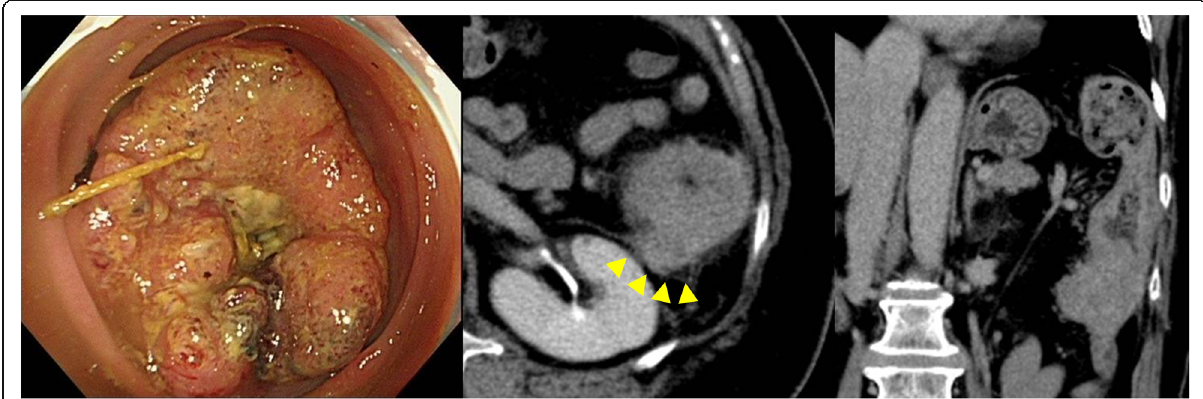
Fig. 1 Colonoscopy and computed tomography: circumferential T4 descending colon cancer invading the Gerota ’ s fascia (arrow head) at the anal side of the splenic